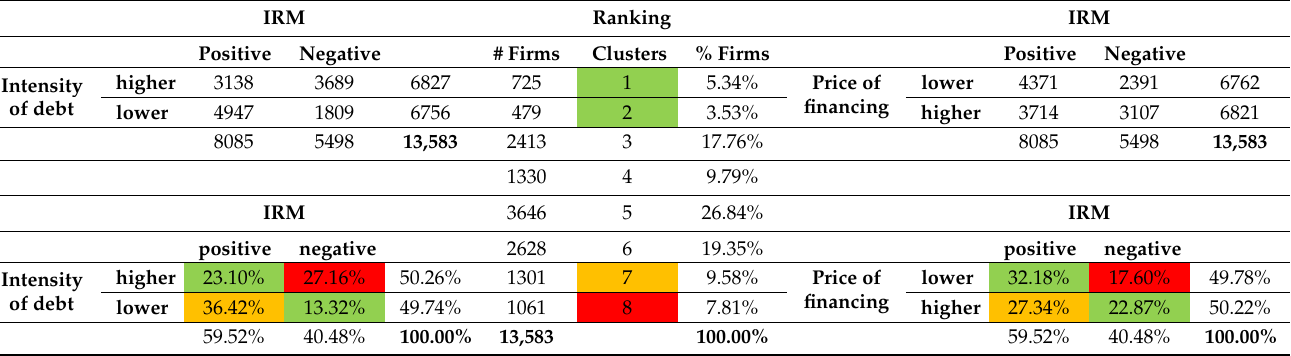
Table 4. Overlaps between IRM results, intensity of debt (left) and price of financing